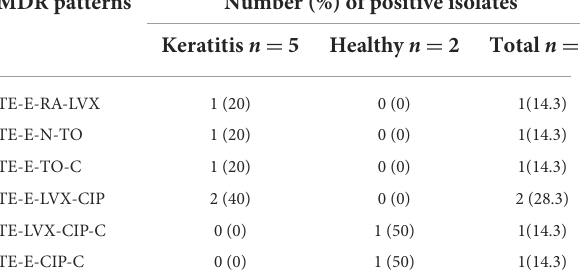
TABLE 6 Distribution of virulence factors genes among 29 isolates of S. pseudintermedius